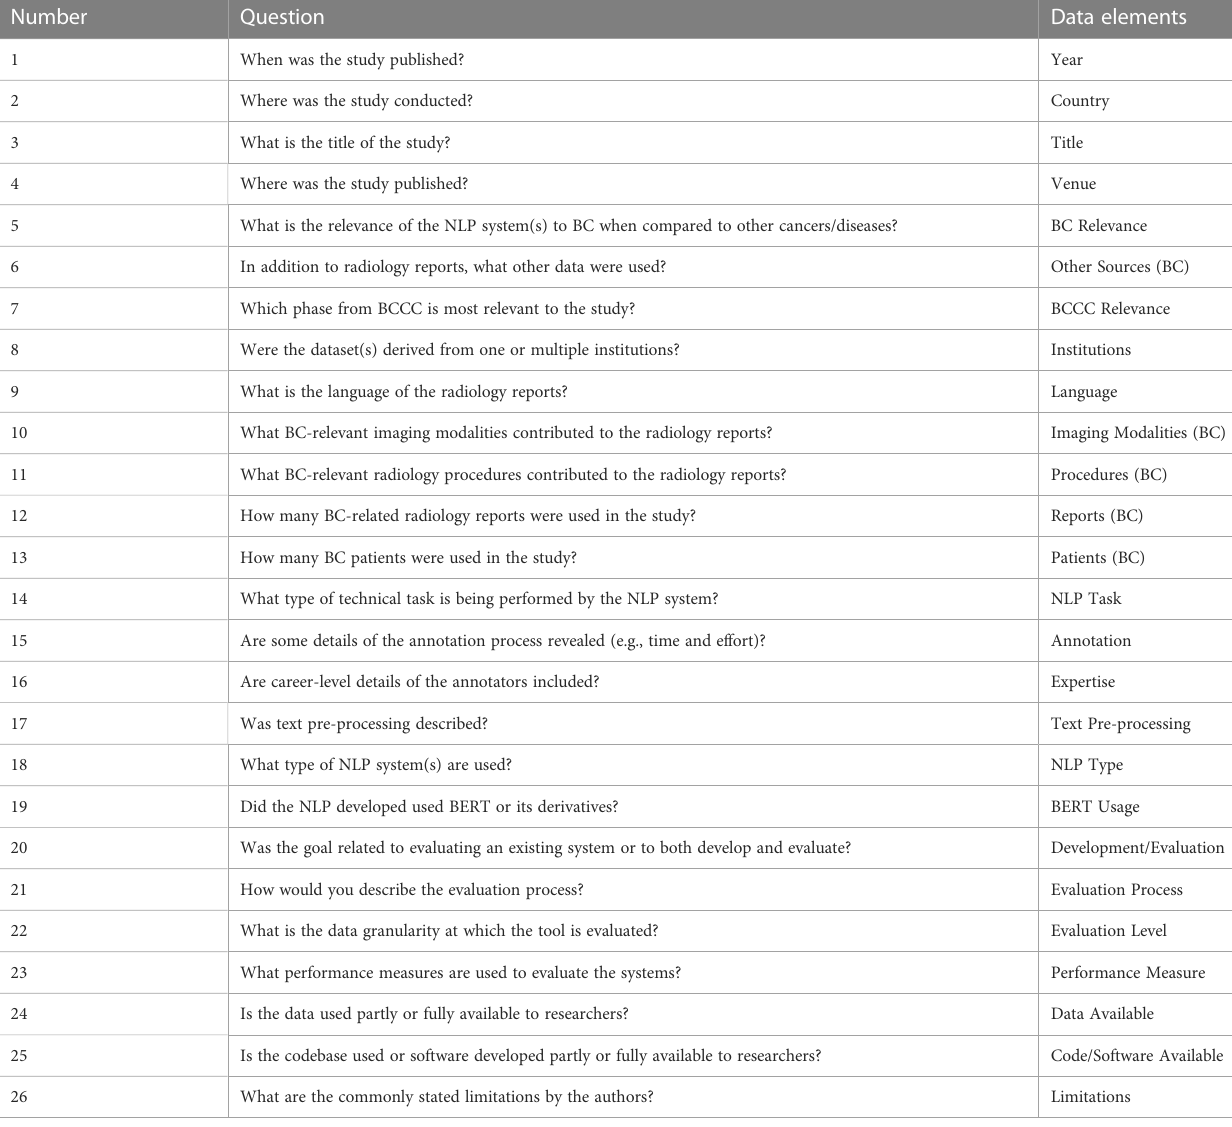
TABLE 1 Questions answered through our study and corresponding data